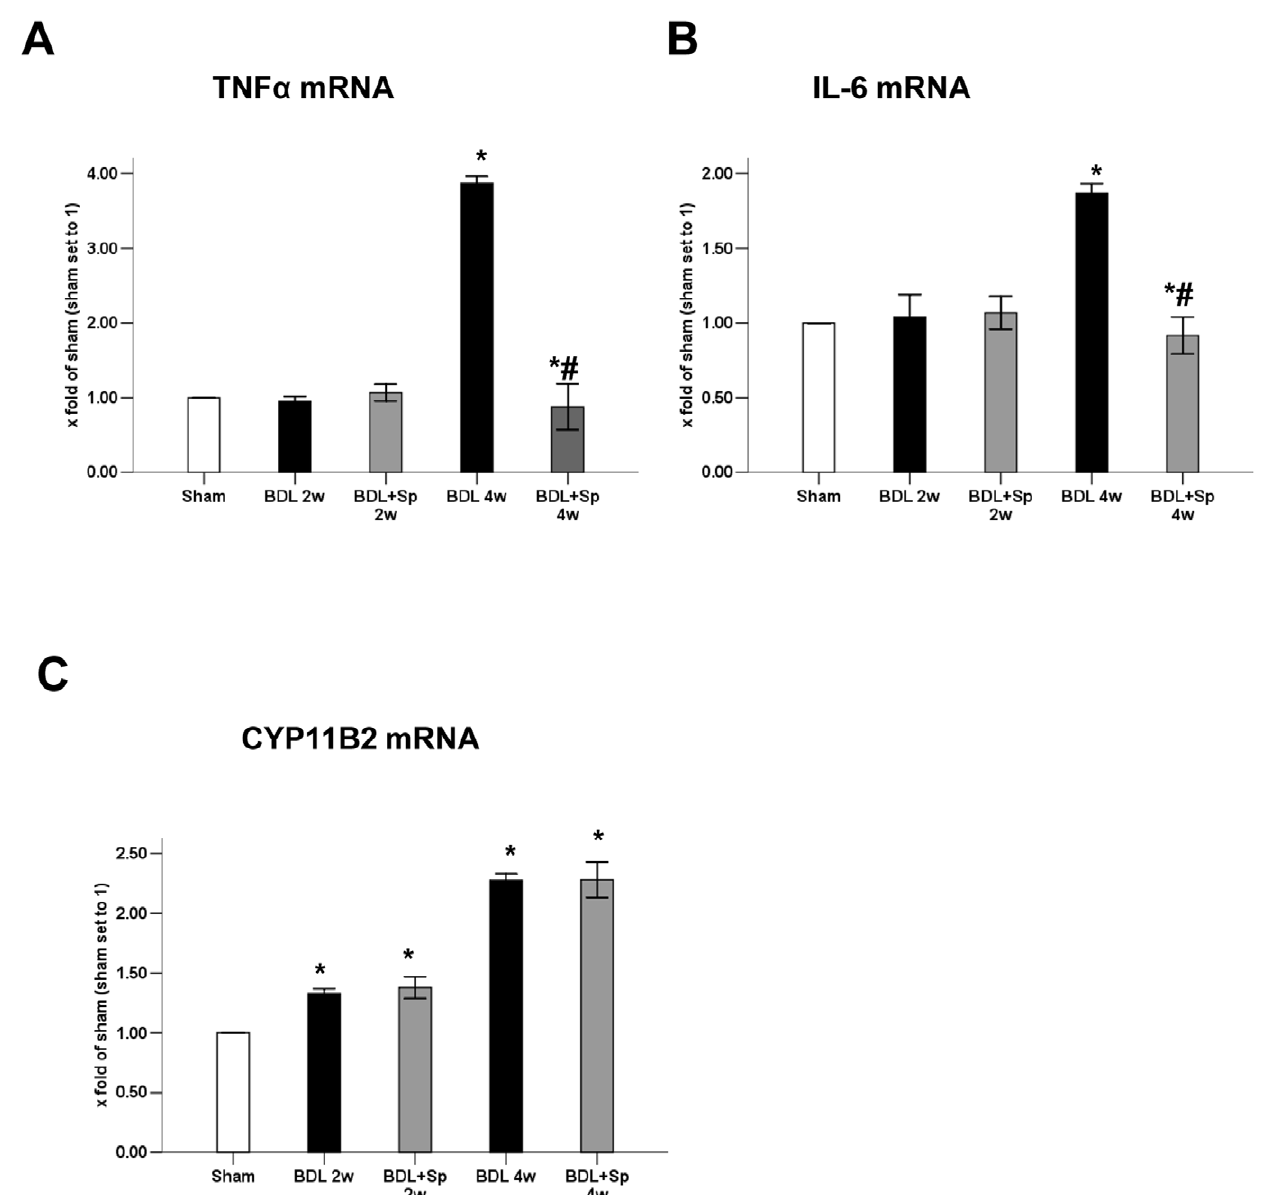
Figure 4. Effects of spironolactone on the inflammatory genes and aldosterone synthase gene expressions in BDL-treated rats. (A) Real-time PCR analysis for TNF a mRNA expression. (B) Real-time PCR analysis for IL-6 mRNA expression. (C) Real-time PCR analysis for CYP11B2 mRNA expression. * p , 0.05 compared to the Sham group. # p , 0.05 compared to the BDL groups.